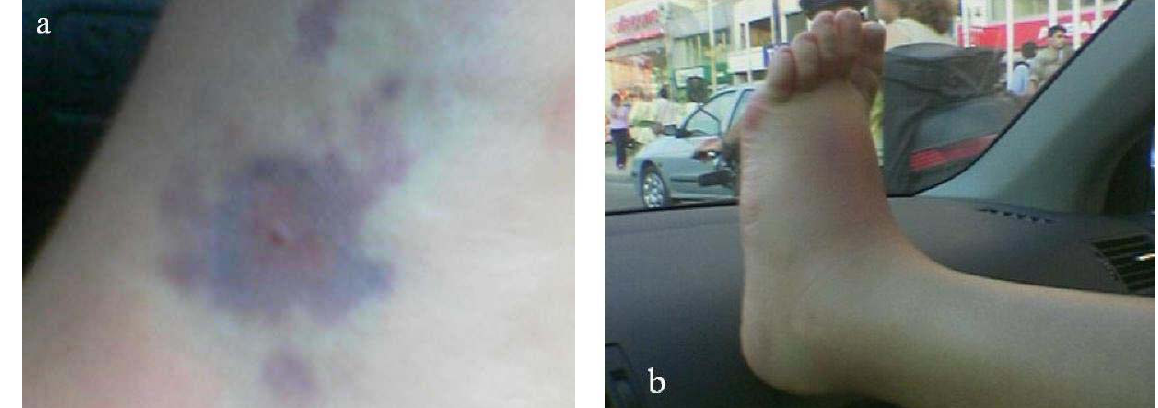
Figure 1. The patient presented erythema and edema. (a) Left foot (dorsal part or left side of the bitten area) while she went to the hospital. (b) Three days after the bite.